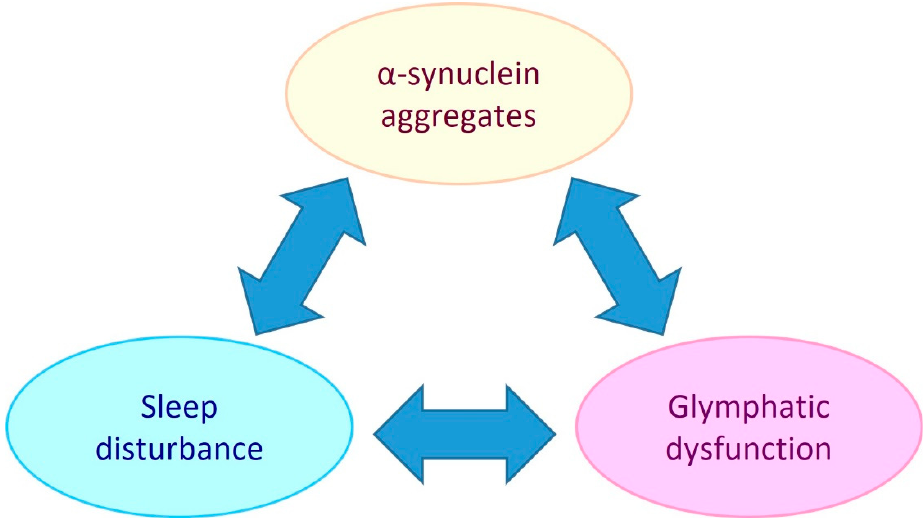
Figure 1. Potential bidirectional relationships between alpha-synuclein aggregate pathology, the glymphatic system and sleep. Sleep disturbance has been shown to be both a risk factor and chronic symptom of PD. Glymphatic dysfunction may contribute to PD by allowing extracellular accumulation of alpha-synuclein and other solutes. PD development may impair the glymphatic system by causing AQP4 depolarisation and reduced sleep. Glymphatic function has been found to be intimately dependent on sleep, so sleep disturbance could be both a symptom of PD and a causative element in PD pathogenesis by reducing glymphatic clearance.